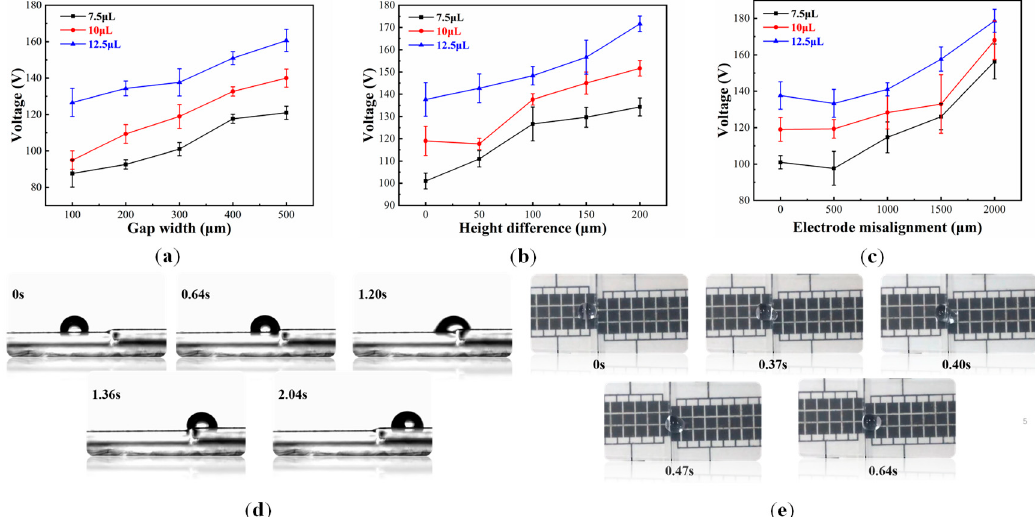
Figure 6. ( a ) Curves of the relationship between minimum driving voltage of droplet and gap width; ( b ) Curves of the relationship between minimum voltage required of droplet and height di ff erence; ( c ) Curves of the relationship between minimum voltage required of droplet and misalignment di ff erence; ( d ) A 10 µ L droplet crossed a splicing gap with a height di ff erence of 150 µ m; ( e ) A 10 µ L droplet crossed a splicing gap with an electrode misalignment of 1000 µ m. The electrode on / o ff time was fixed at 600 ms, and the splicing gap width was fixed at 300 µ m.